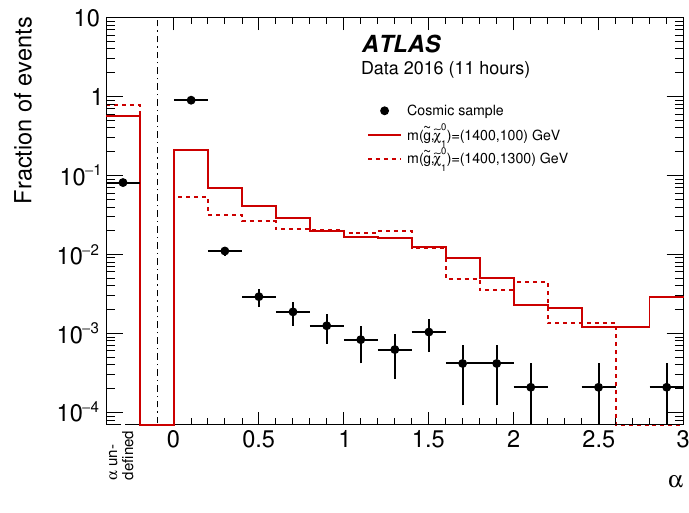
Figure 4 . The α distribution is shown for events passing preselection requirements in the cosmic sample. Example signal models with a gluino mass of 1 . 4 TeV and mass differences ∆ m = 100 GeV and 1300 GeV are overlaid. In cases where all eligible muon segments reside in one hemisphere of the detector, or where no segments have been reconstructed in the event, α cannot be calculated. The first bin represents the events for which α cannot be calculated because the imposed requirements are not met. The last bin contains the